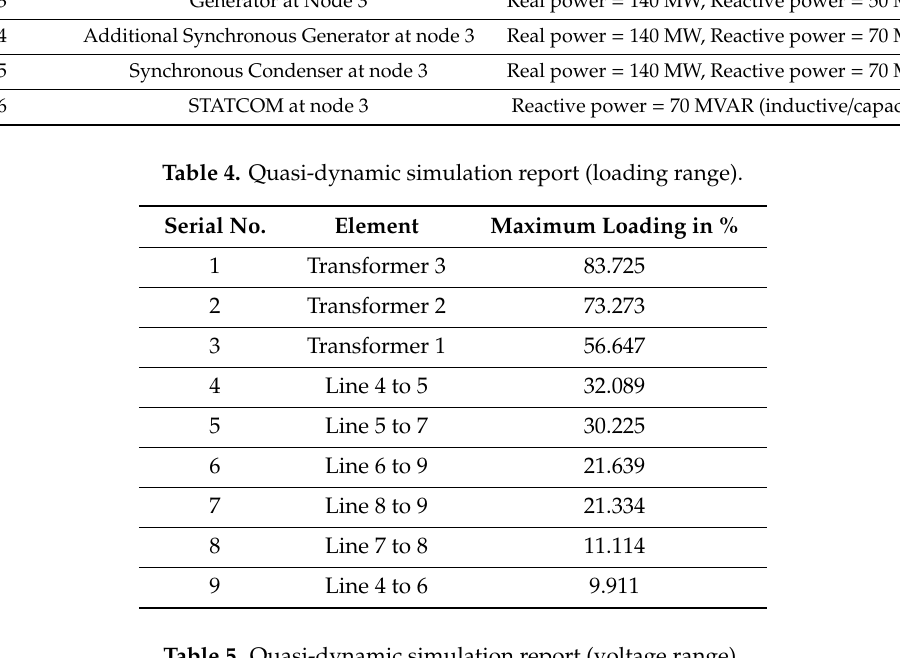
Table 5. Quasi-dynamic simulation report (voltage